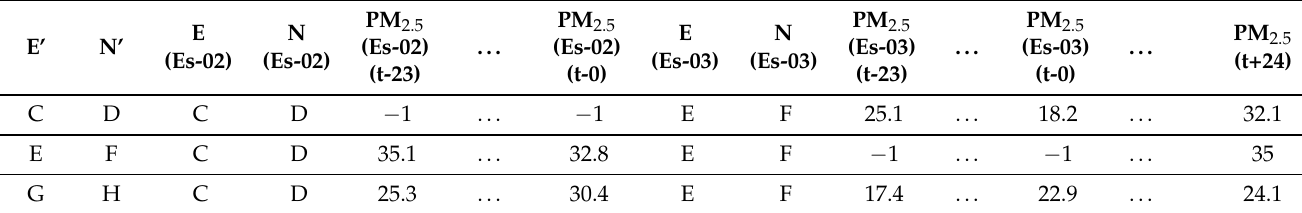
Table 6. Structure of dataset used in spatio-temporal